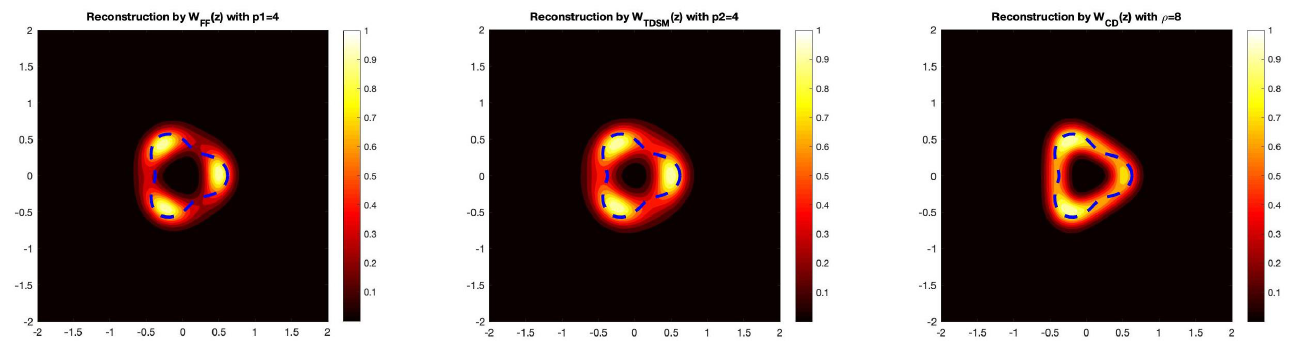
Figure 2. The reconstruction of the acorn-shaped obstacle by the three direct sampling methods. In this example, we take δ = 0.05, which corresponds to a 5% noise